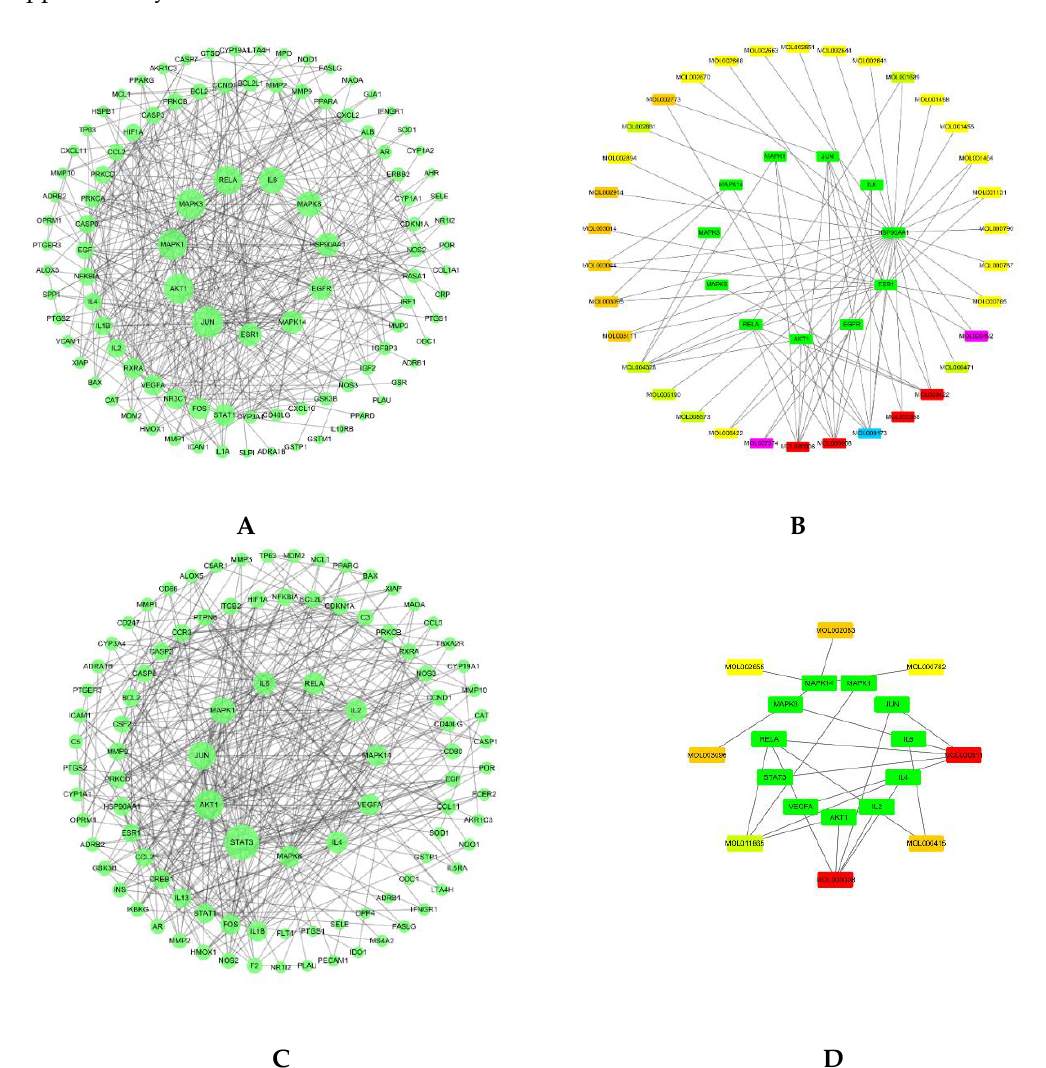
Figure 3. Protein–protein interaction (PPI) and network analysis. ( A ) PPI analysis of intersection targets between compound (OB ≥ 30% and DL ≥ 0.18) and AD-related targets, and ( B ) network analysis of screened core genes and related compounds. ( C ) PPI analysis of intersection targets between compound (OB < 30% and DL ≥ 0.18) and AD-related targets, and ( D ) network analysis of screened core genes and related compounds. The light gray circles represent intersection targets. The circles get larger with increasing degree. The Kelly green, yellow, orange, blue, and violet rectangles represent compounds from HM, CP, FL, RA, and CM, respectively. The red rectangles represent compounds from more than two herbs in PHF. The green rectangles represent core targets against AD. PHF: Pentaherbs Formula; AD: atopic dermatitis; OB: oral bioavailability; DL: drug-likeness; CM: Cortex Moutan; CP: Cortex Phellodendri; FL: Flos Lonicerae; HM: Herba Menthae; RA: Rhizoma